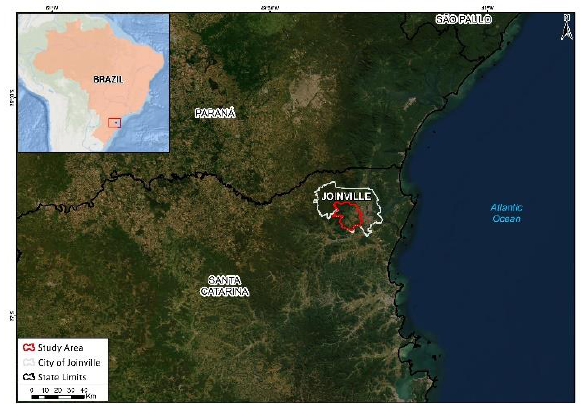
Figure 1: Location of the study area in Joinville/SC.